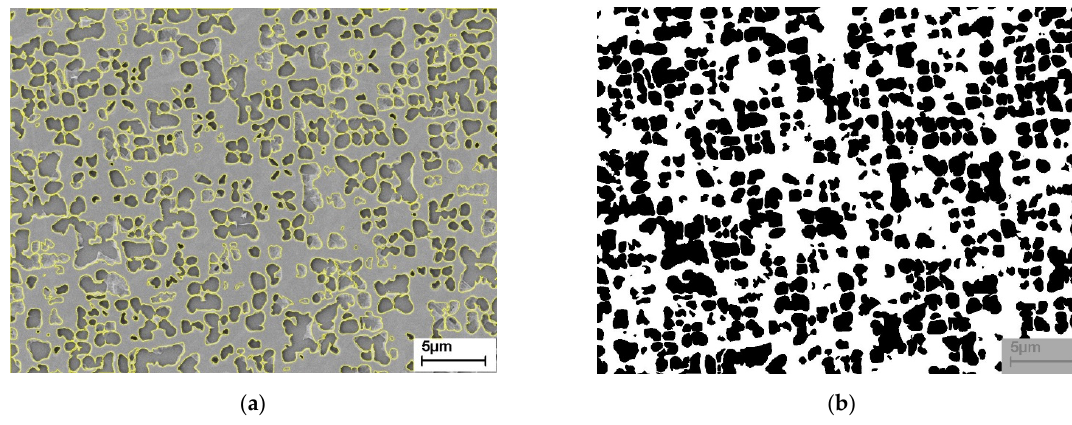
Figure 2. γ / γ′ microstructure: ( a ) outline of the γ′ -precipitates drawn in ImageJ; ( b ) binarized microstructural image Figure 2. γ / γ (cid:48) microstructure: ( a ) outline of the γ (cid:48) -precipitates drawn in ImageJ; ( b ) binarized microstructural image where where the γ′ -precipitates are black and the γ -matrix is white. the γ (cid:48) -precipitates are black and the γ -matrix is